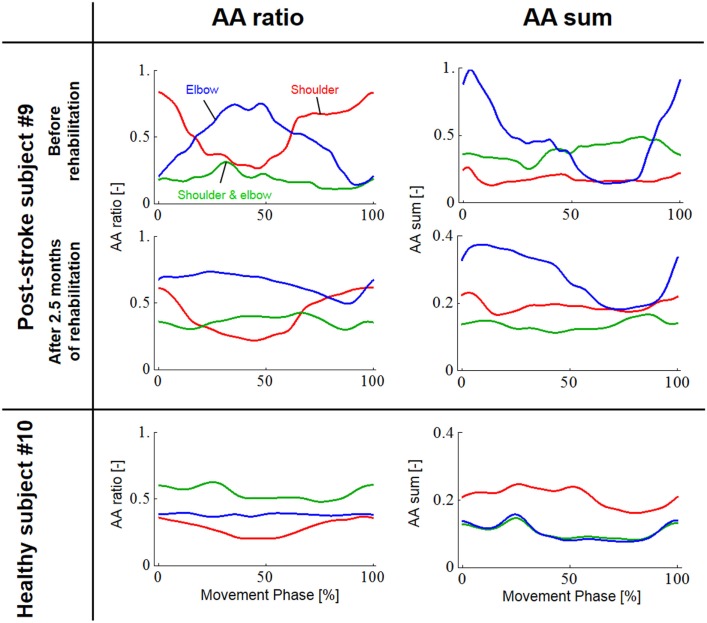
Change in the agonist–antagonist (AA) ratios and AA sums for the post-stroke subject before and after 2.5 months of rehabilitation. The red, green, and blue lines indicate the change in the time-dependent explanatory variable for the AA muscles around the shoulder, shoulder and elbow, and elbow joints, respectively. Each data set was normalized with respect to a period of movement time. The changes in the AA ratio and AA sum indicate that rehabilitation resulted in change in the control of EP and stiffness around each joint. In particular, the AA sum was improved although it was still far from the level observed from the healthy subject. (Note the different range of the graphs for AA sums before and after rehabilitation.)